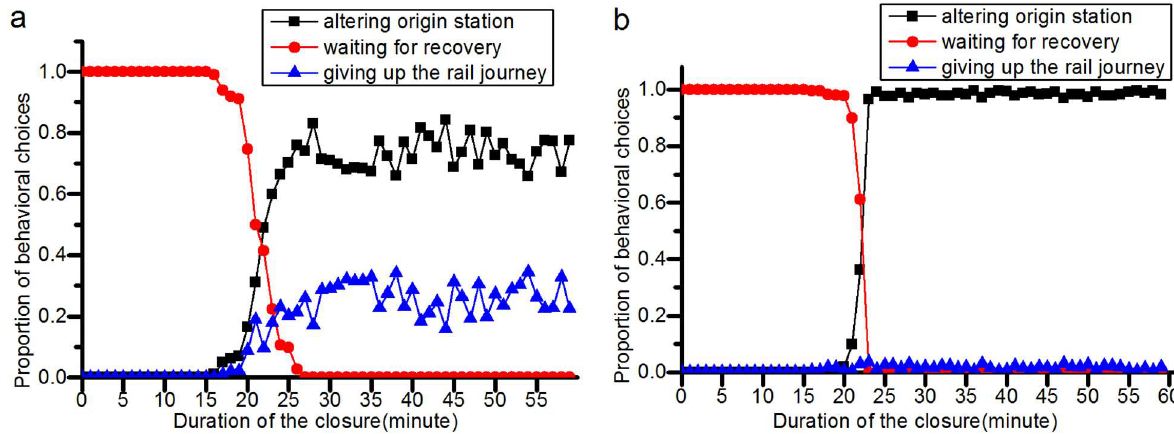
Fig 16. The relationship between the closure duration and the passenger behavioral choices. (a) representsthe simulationresults in the JISHUITAN case. (b) denotes the simulationresults in the TIANTONGYUAN